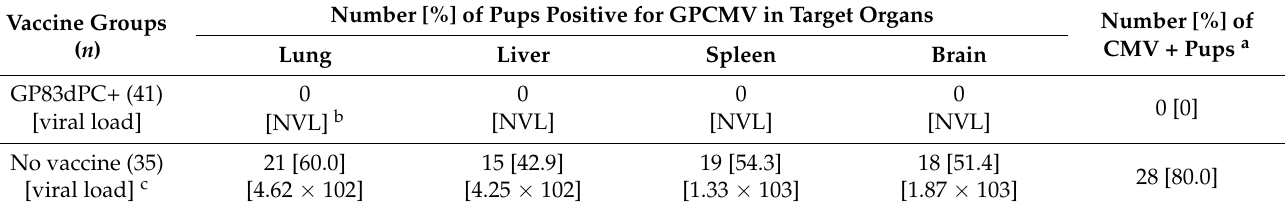
Table 2. Congenital infection outcome in pups based on viral load in target